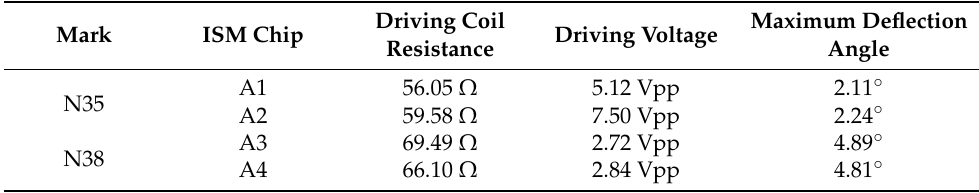
Table 3. Test results of electromagnetic ISM with straight torsion beam.